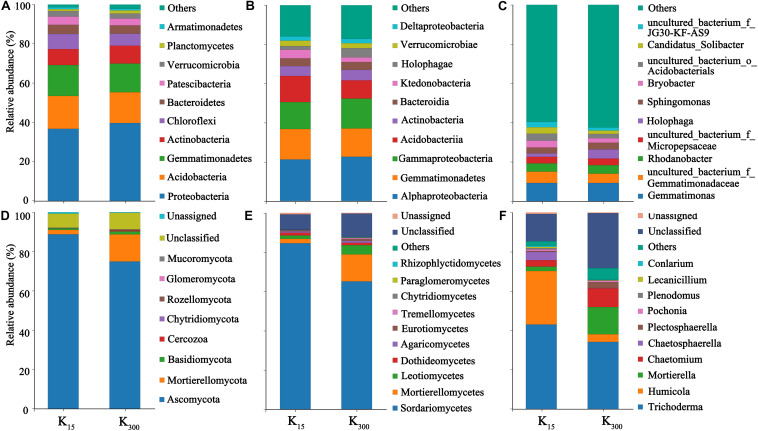
Effect of different amounts of K2SO4 on the community composition and relative abundance of Bacteria (A, Phylum; B, Class; C, Genus), Fungi (D, Phylum; E, Class; F, Genus) in P. notoginseng planting soil in 2018 (K15, 15 kg⋅ha–1; K300, 300 kg⋅ha–1).